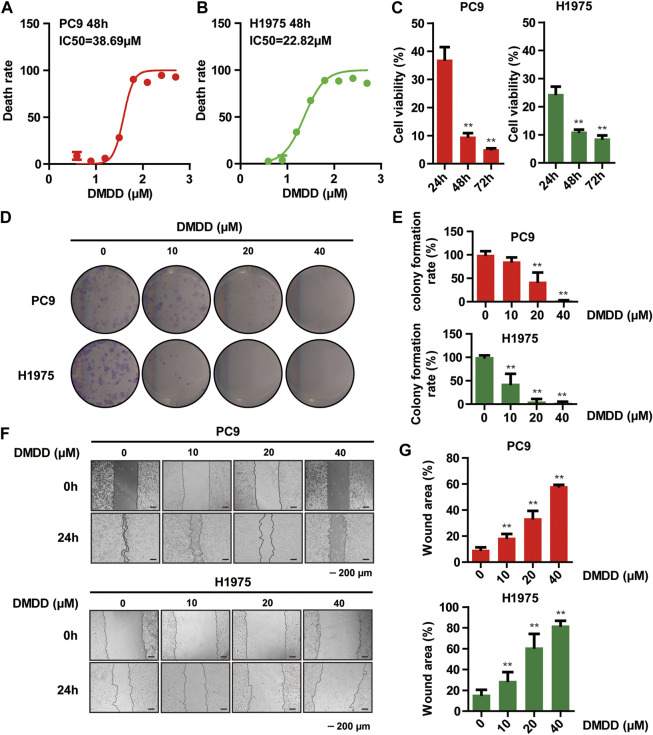
DMDD Inhibits proliferation, migration and colony formation in lung cancer Cells. (A, B) Dose-dependent curves of DMDD in PC9 and H1975 cell lines. (C) Cell proliferation decreased after 60 µM DMDD treatment in PC9 and H1975 cell lines at indicated time. (D) Colony formation in PC9 and H1975 cells after treatment with DMDD at 0, 10, 20 and 40 µM. (E) Bar chart shows the colony formation rate calculated from Figure 5D. (F) Cell migration was determined using a wound-healing assay. Images of the wound areas were shown at 0 and 24 h in PC9 and H1975 cell lines (scale bar 200 μm). (G) Bar chart shows the wound area calculated from Figure 5F. Data are shown as mean ± SD. *p < 0.05, **p < 0.01.